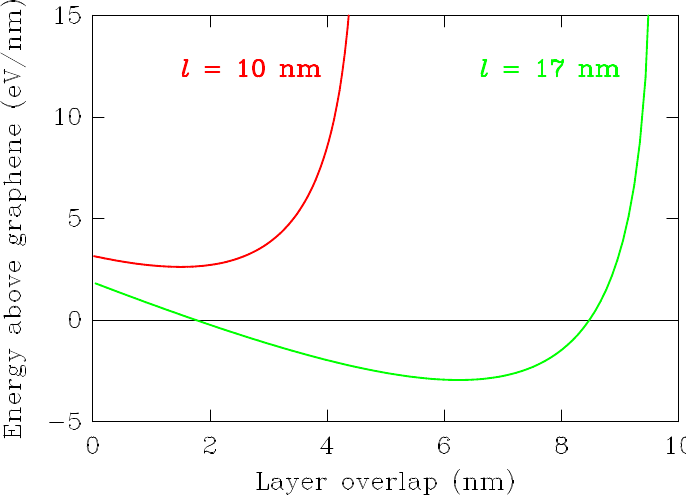
Figure 4. Total energy per depth unit above that of flat graphene of a scrolled sheet such as displayed in Figure 3 as a function of the length of the overlapping part. The two curves correspond to a sheet of length l of 10 and 17 nm,